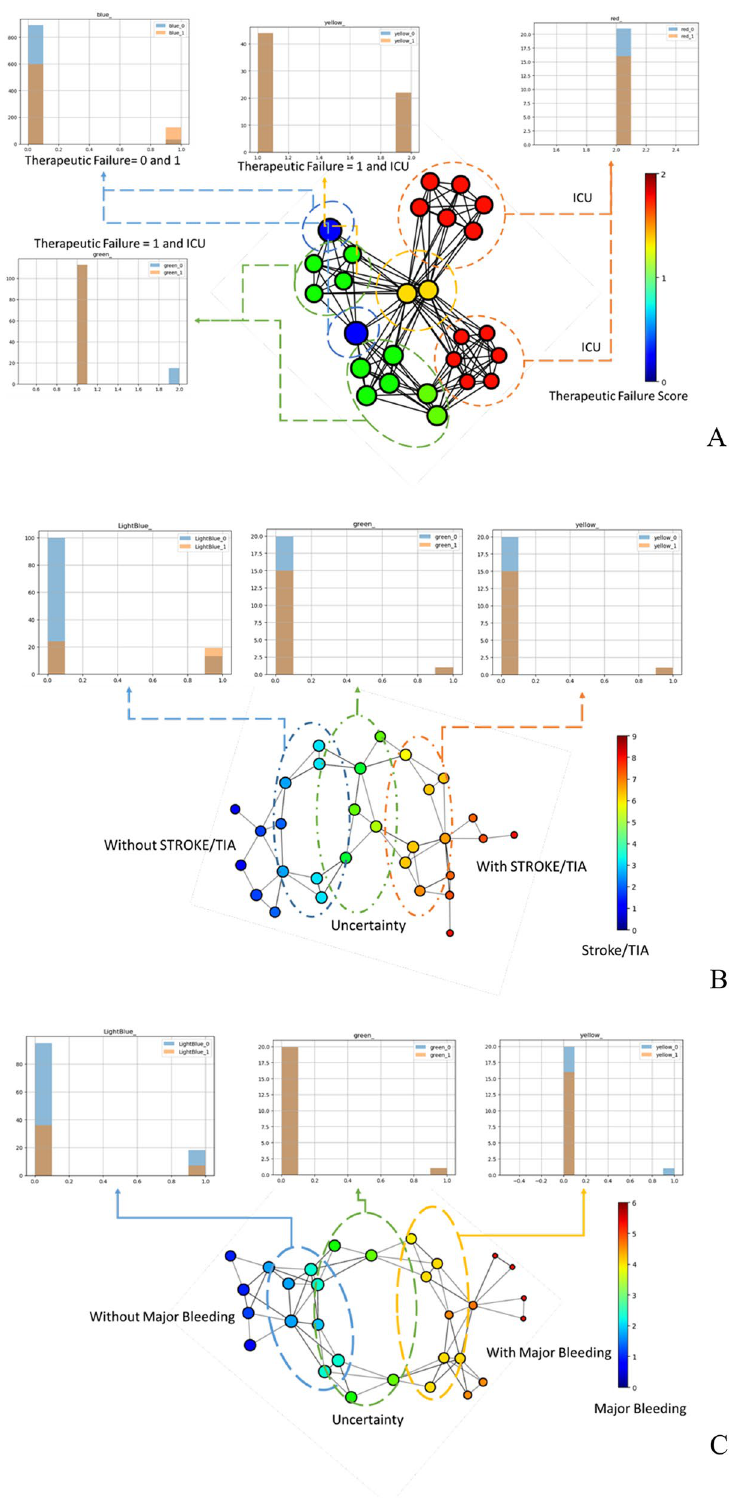
Figure 1. Topological data analysis results for ( A ) “therapeutic failure”; ( B ) “stroke/TIA” and ( C ) “major bleeding”. This output figure has been generated with Kepler Mapper 2.0.1 24 . Legend: ICU = intensive care